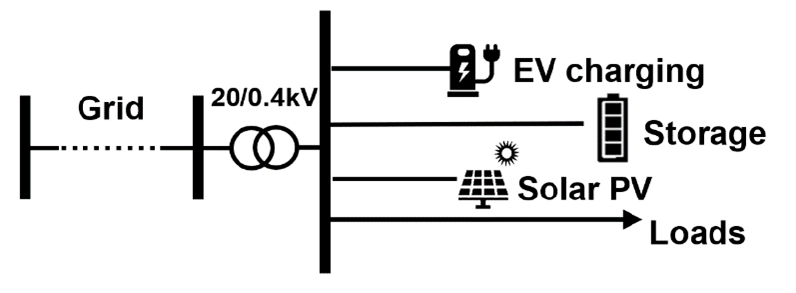
Figure 1. Component-wise view of use-case’s local